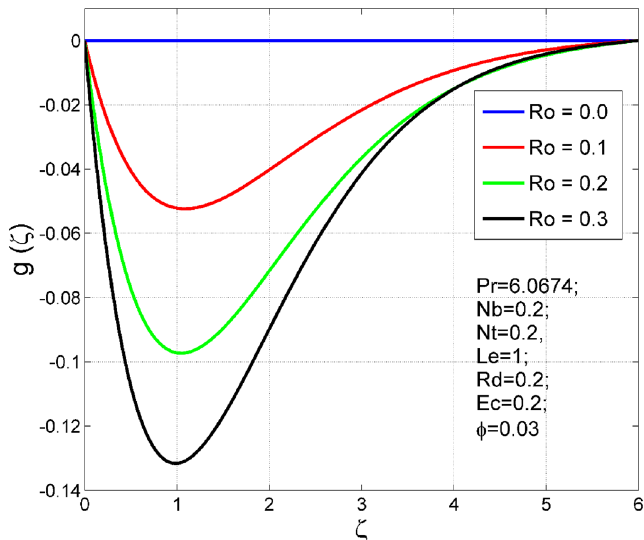
Figure 3. Effect of Ro on g (ζ) .